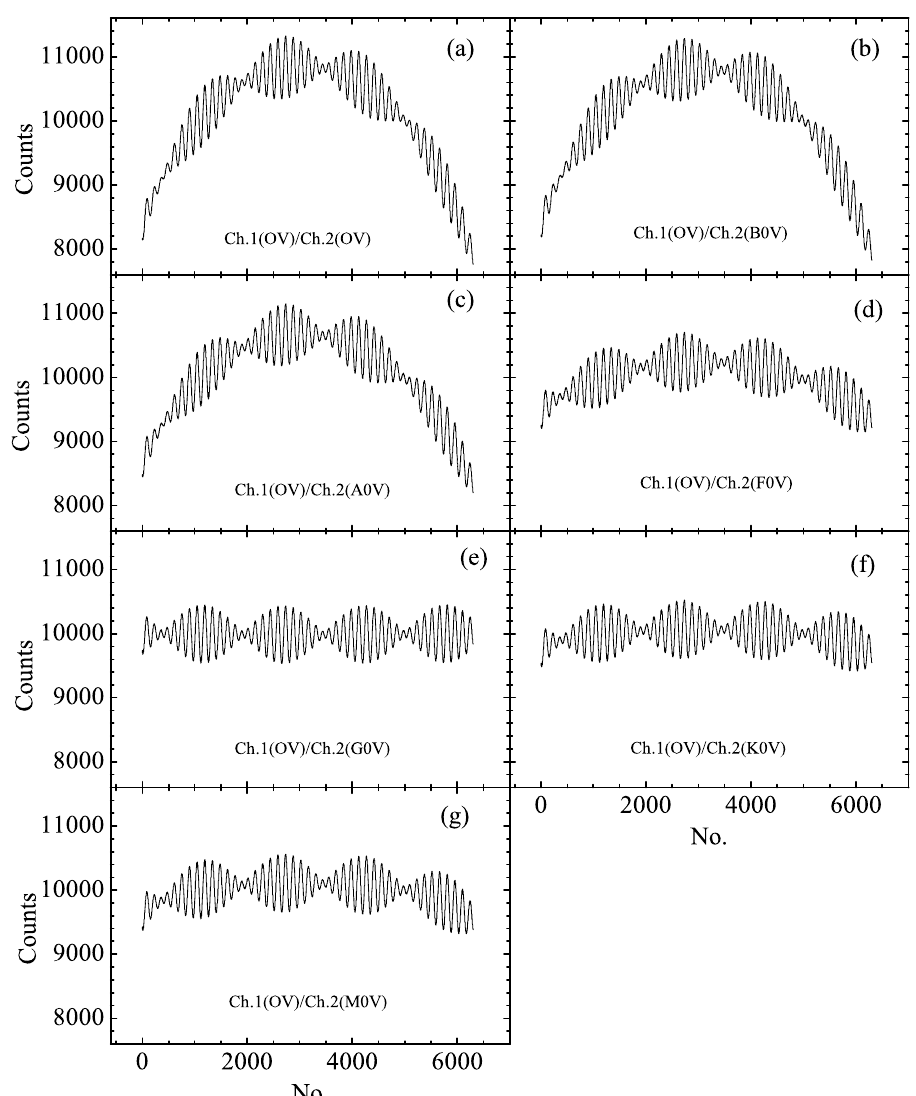
Fig. 13. Determination of spectral type of the comparison star using the new extinction correction method for synthetic observations, when the light curve of the program star is divided by the light curve of the comparison star, assuming different spectral types for the comparison